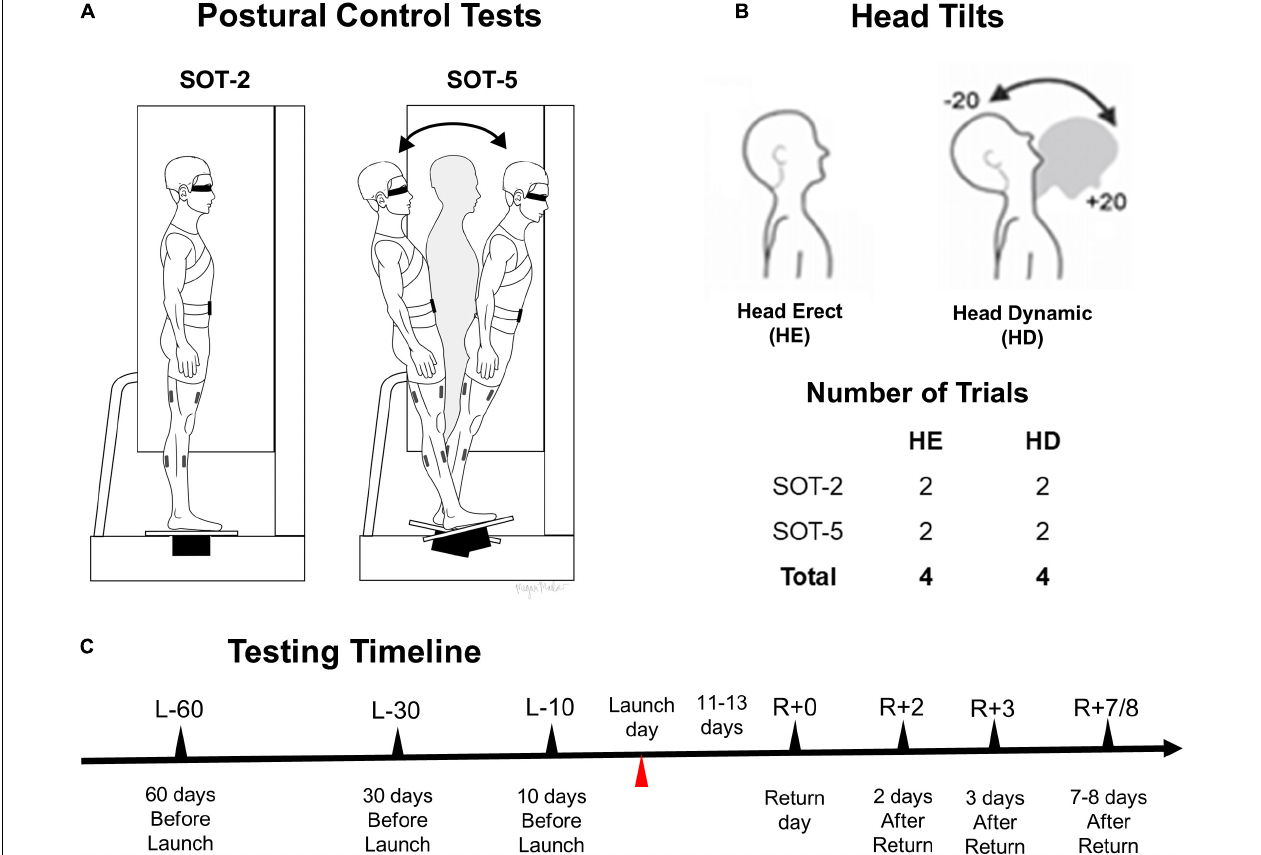
FIGURE 1 | A schematic representation of study protocols and experimental conditions. Postural control tests (stable support surface, SOT-2 and sway-referenced support surface, SOT-5) are shown in (A) , while head conditions and number of trials for each postural control test are shown in (B) . (C) Shows a timeline of each session. All trials were conducted with eyes